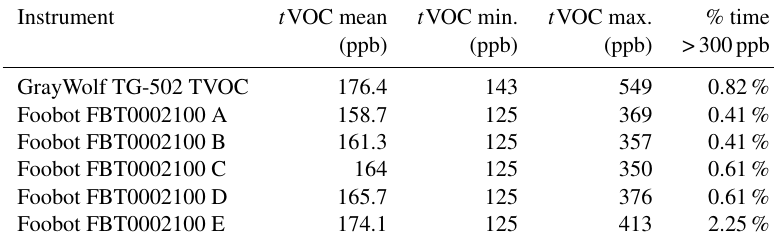
Table 3. Summary statistics for t VOC calibration dataset divided by instruments.